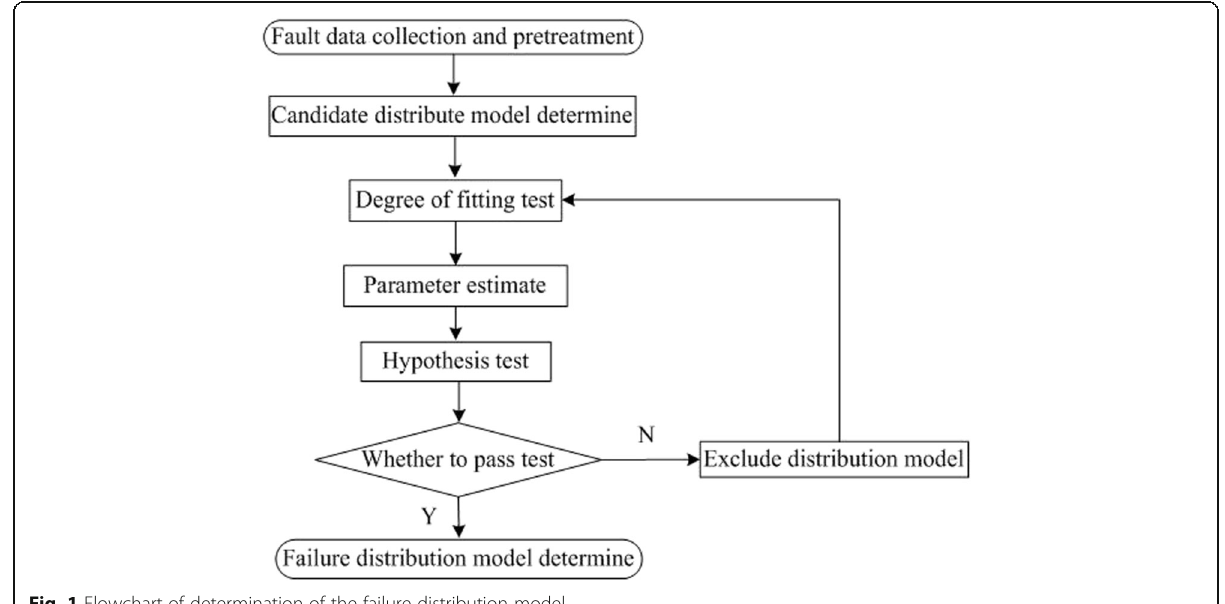
Fig. 1 Flowchart of determination of the failure distribution